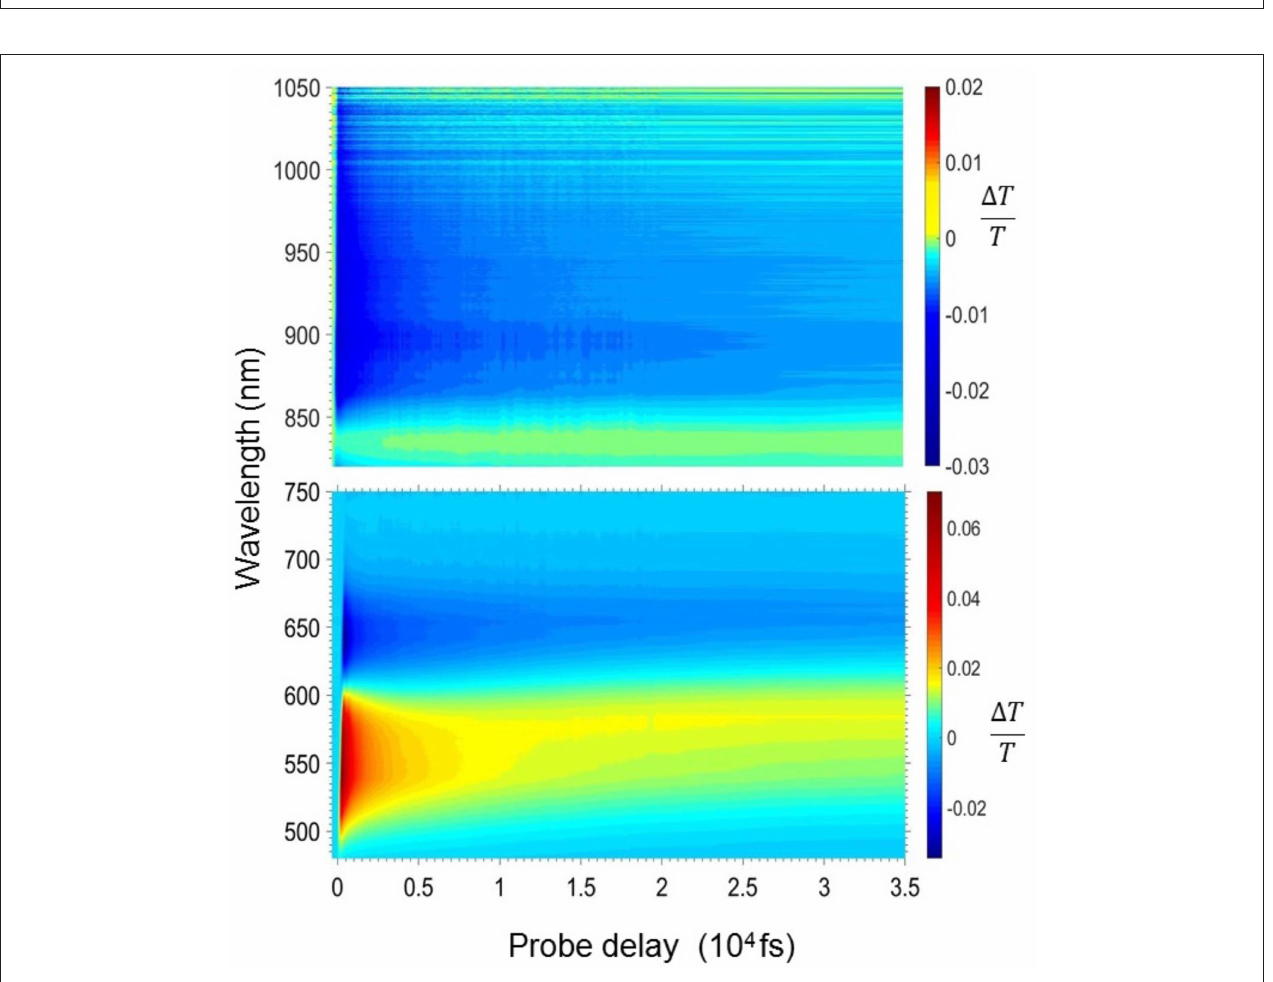
FIGURE 2 | 2-Dimensional 1 T / T map in the visible (bottom panel) and the near infrared (top panel) region for the HMM nanoparticle suspension.